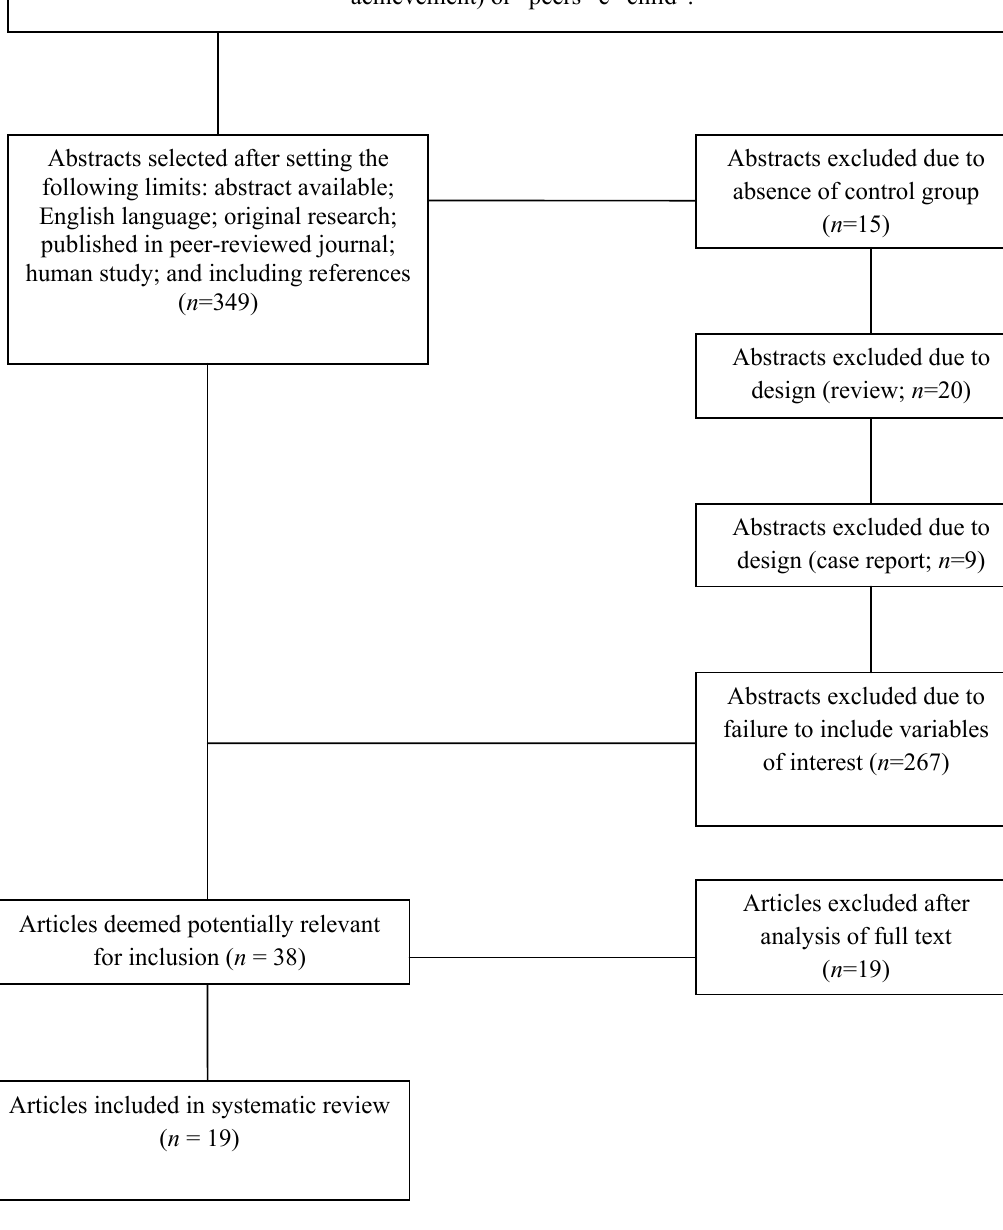
Figure 1 . Article selection fl